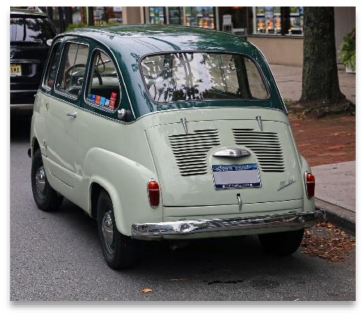
Figure 2. FIAT 600 Multipla—year 1956.